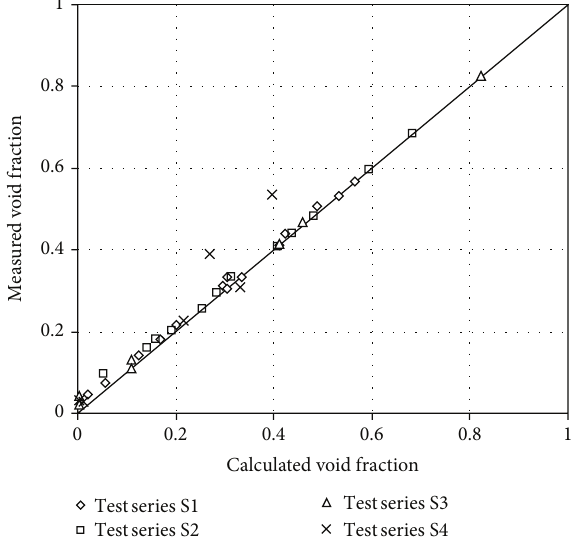
Figure 17: Deviation of measured quality from recalculated quality for test series 5.